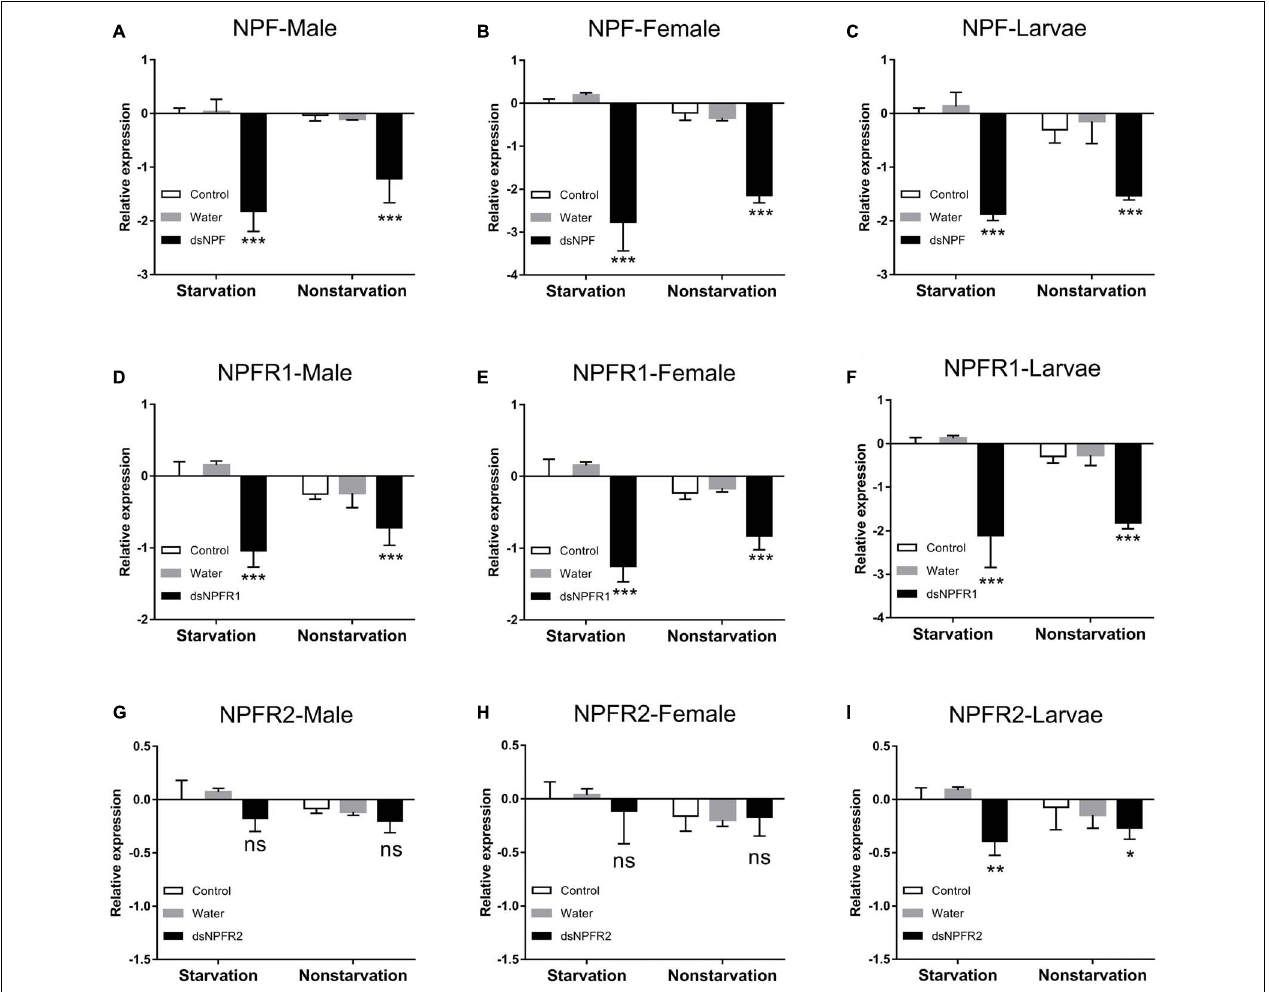
FIGURE 4 | Knockdown of NPF-Male (A) , NPF-Female (B) , NPF-Larvae (C) , NPFR1-Male (D) , NPFR1-Female (E) , NPFR1-Larvae (F) , NPFR2-Male (G) , NPFR2-Female (H) , and NPFR2-Larvae (I) expression levels in D. armandi after injecting dsRNA for 72 h in the state of starvation and non-starvation. The asterisk indicates a significant difference between control and RNAi treatments according to Student’s t -test (* P < 0.05, ** P < 0.01, *** P < 0.001, ns, not significant). All values are mean ± SE , n =